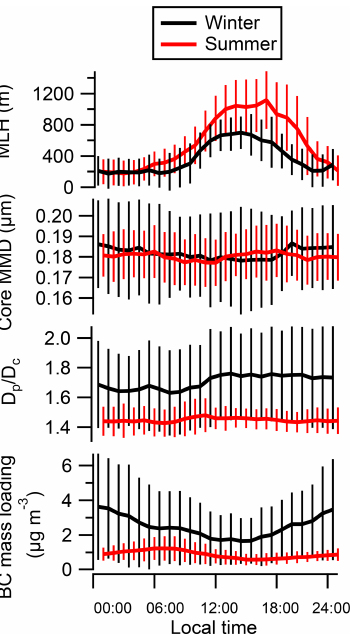
Figure 6. Diurnal variations of mixing layer height (MLH) and BC- related properties in winter and summer. The lines show the mean at each hour and error bars denote ± 1 σ . The x value for summer is shifted by 0.5h to avoid the overlap.